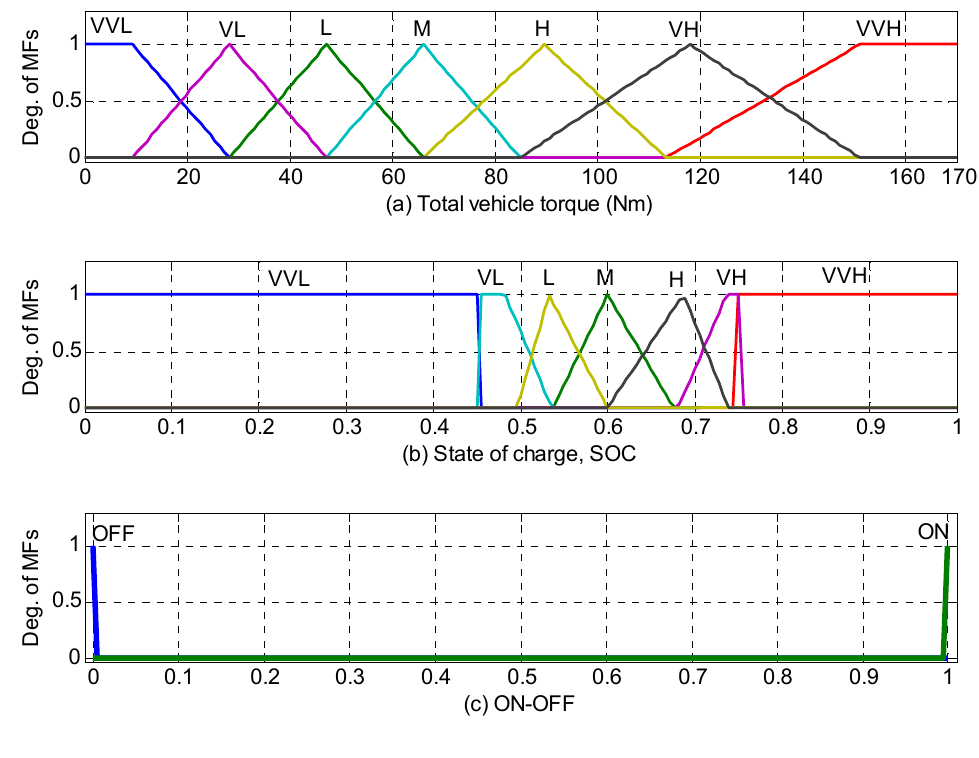
Figure 5. Membership functions of fuzzy ON/OFF controller variables of the ICE: ( a ) Vehicle torque; ( b ) SOC of battery; ( c ) Switching state of the engine